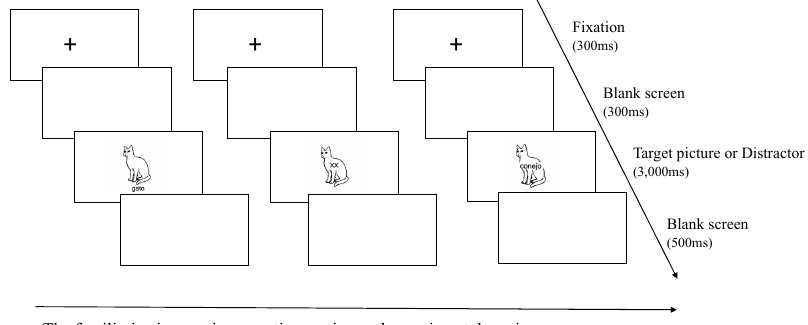
Figure 1. Illustration of the familiarization session, practice session and experimental session for the picture naming task.